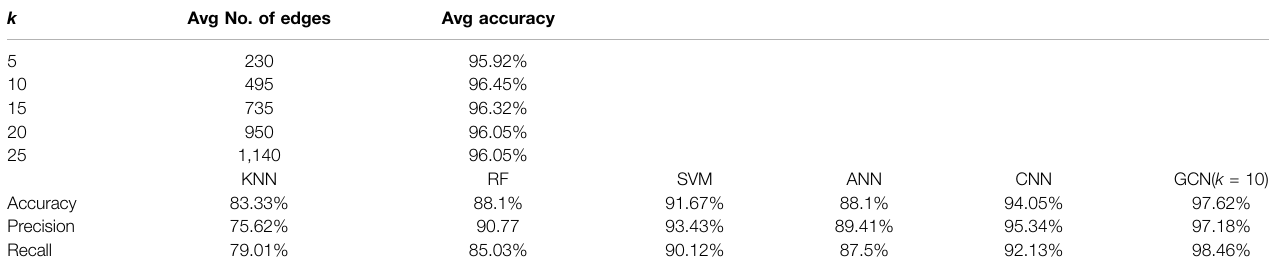
TABLE 2 | Effect of Different k in the graph of GCN and comparison with other algorithms on HideMyGaze! dataset. k Avg No. of